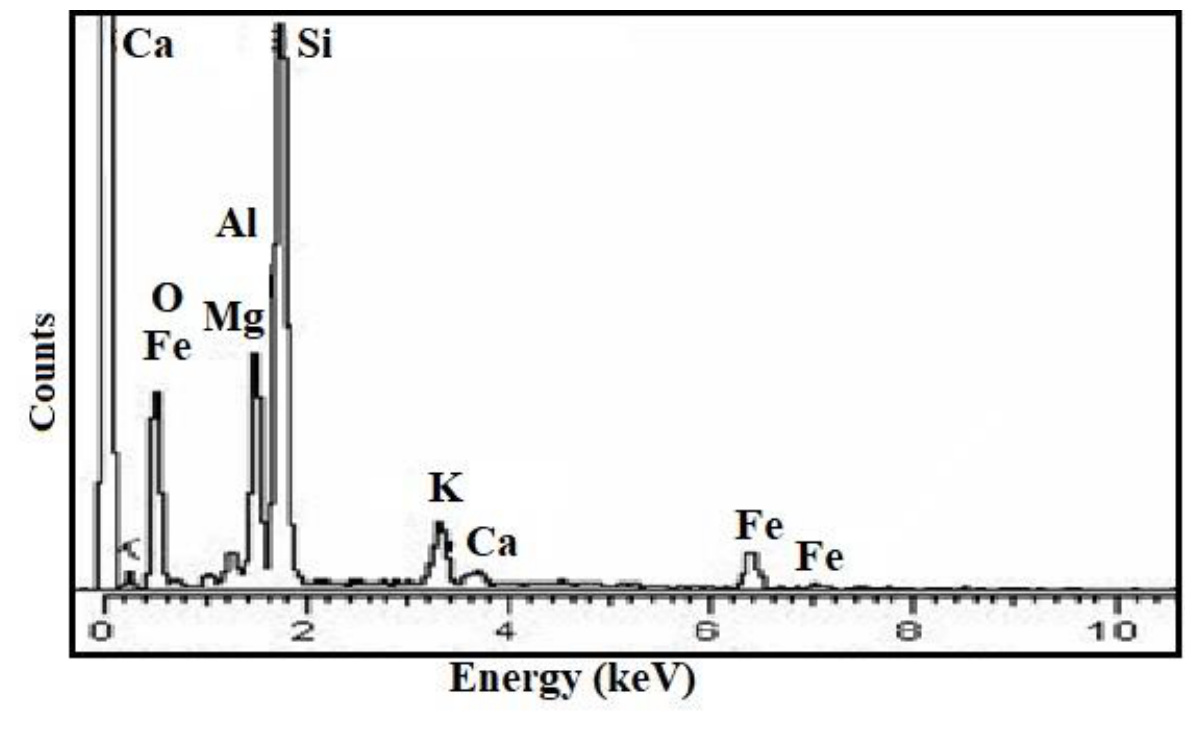
Figure 2. SEM image of anthill catalyst .